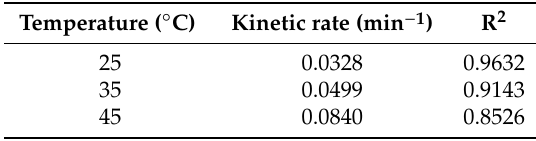
Table 2. Impact of temperature on the RhB removal kinetic rate under the CH 3 NH 3 PbI 3 /visible irradiation